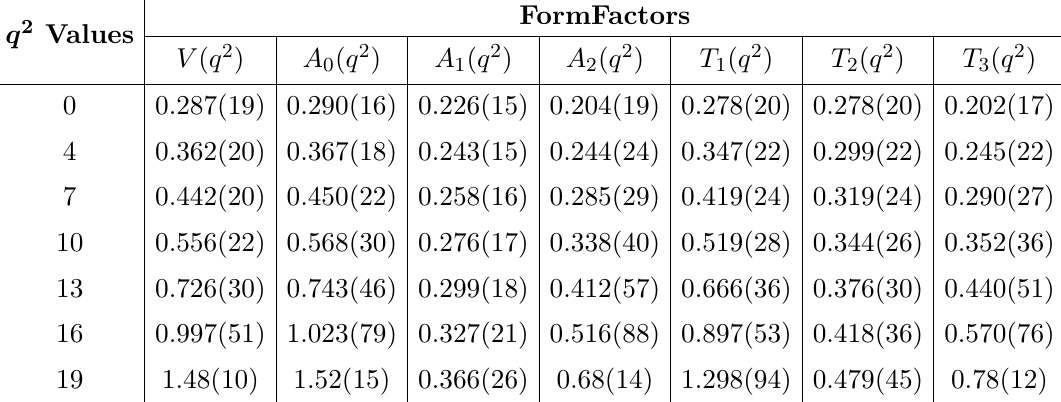
Table 13. Values of the different B → ρ form factors (for n=3) corresponding to a few q 2 values within the allowed kinematical region for the B → ρ semileptonic transitions after the inclusion of the Babar